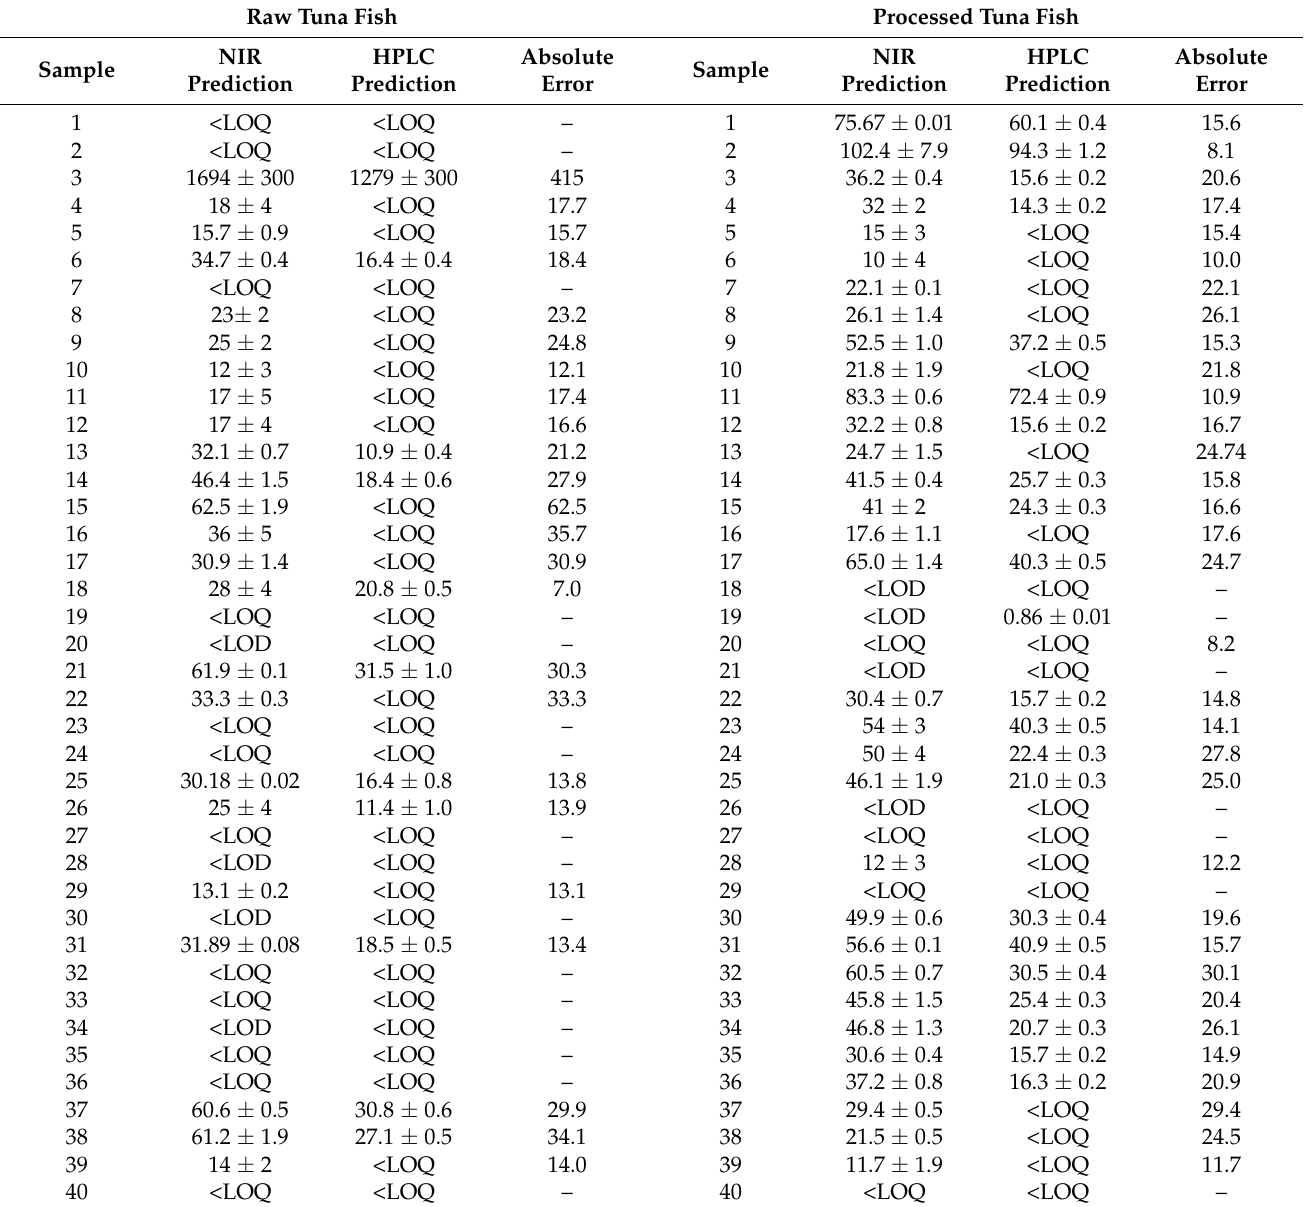
Table 2. Comparison of NIR and HPLC performances in predicting histamine content in testing tuna samples. Raw Tuna